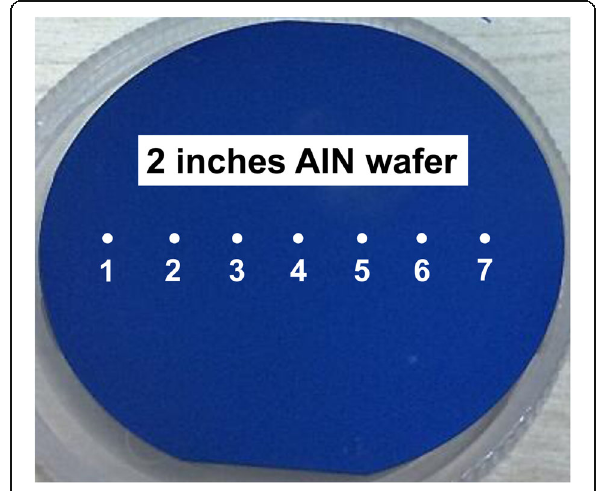
Fig. 2 Schematic points for the thickness measurement of AlN/Si (100)